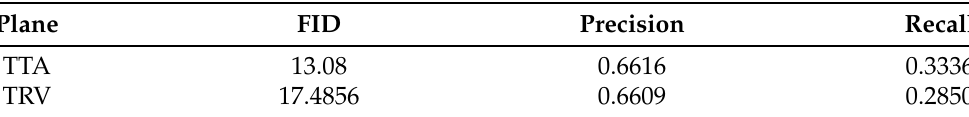
Table 2. Metrics: FID, precision and recall for TTA and TRV